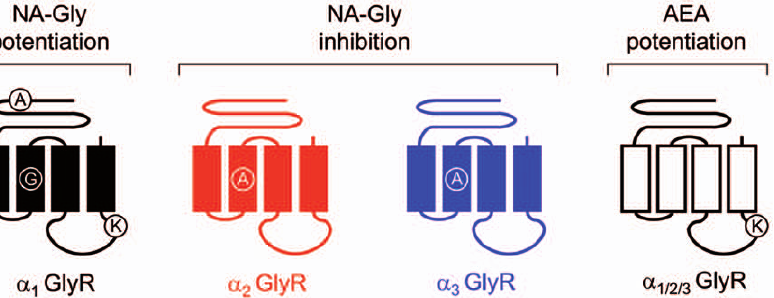
Figure 9. Molecular sites for the allosteric modulation of different GlyR subtypes by ECs. The schematic diagram summarizes the molecular sites for the allosteric modulation of GlyRs by acidic and neutral ECs. The inhibition of a 2 and a 3 GlyRs elicited by NA-Gly was specifically influenced by a single TM2 residue (A261 in a 2 GlyRs and A265 in a 3 GlyRs), whereas the NA-Gly-induced potentiation of a 1 GlyRs was reduced by mutating loop 2 (A52), TM2 (G254) or intracellular (K385) amino acids. On the other hand, the AEA-induced potentiation of these three GlyR subtypes was reduced by mutating a conserved intracellular lysine residue (K385 in a 1 GlyRs).